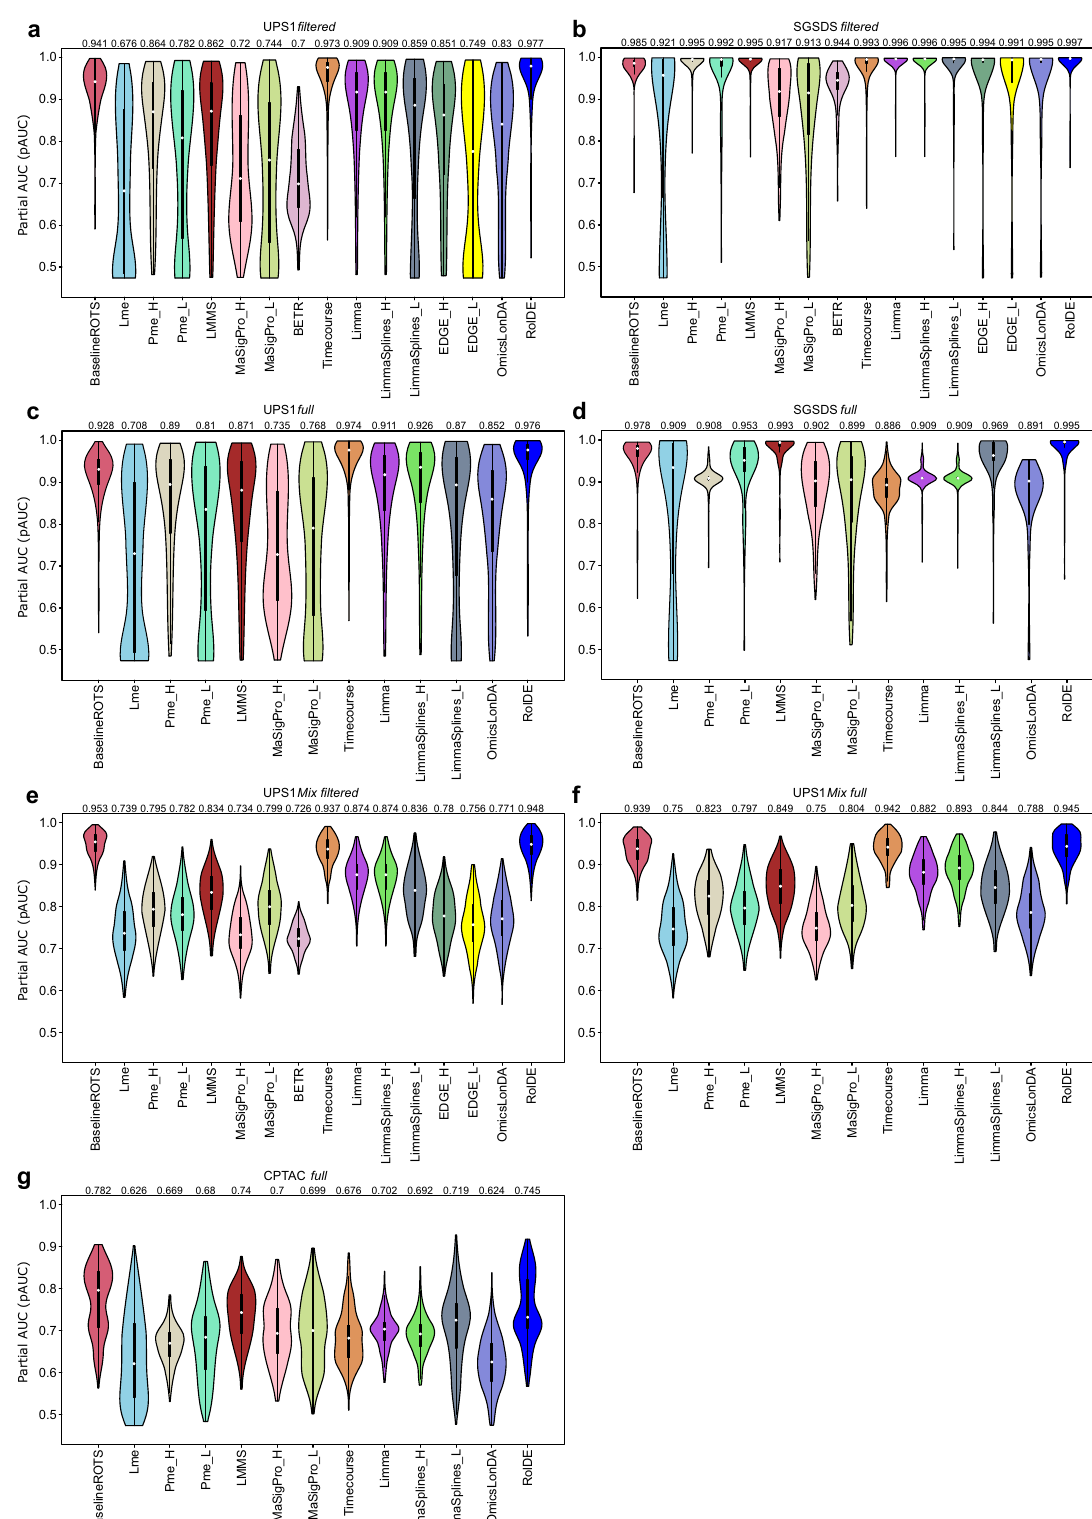
proteins (3 replicate samples per condition). The partial areas under the ROC curves (pAUC) between the speci fi city of 1 and 0.9 were used to measure the performanceofthemethods.TheviolinplotsdisplaythedistributionofpAUCsfor each method, including median (white circle), interquartile range (IQR) from the fi rst to third quartile (black box), and 1.5* IQR (whiskers). The IQR mean pAUC for eachmethodisshownabovetheviolin.Eachmethodisshownwithauniquecolor. Source data are provided as a Source Data fi